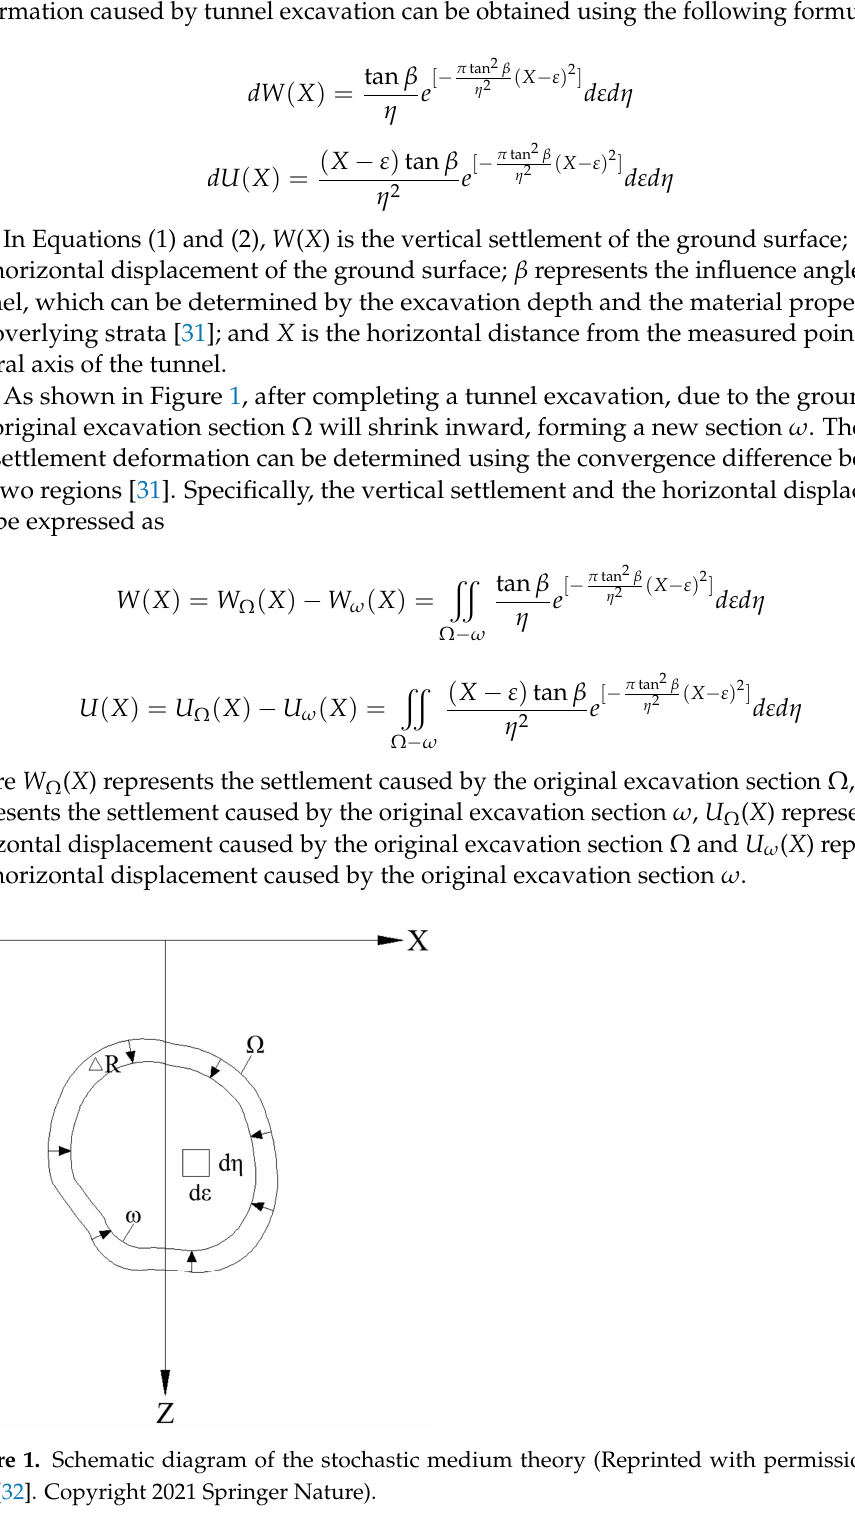
( b ) Figure 2. Horseshoe section of a tunnel: ( a ) uniform convergence and ( b ) non-uniform convergence. (Reprinted with permission from Ref. [32]. Copyright 2021 Springer Nature.). For the horseshoe tunnel section, under the condition of uniform convergence, the uplift of the fl oor is zero, and the tunnel section will move down by Δ R compared with the uniform convergence. In fact, fl oor heave is inevitable during excavation because of the induced stress release. According to Han and Li [33], the cross-section of a horseshoe tunnel can be divided into a semi-elliptical cross-section and a rectangular cross-section, and its horizontal deformation can be obtained via superposition of the two as follows: ( ) ( ) ( ) rrectangulaelliptical XUXUXU += (5) where U(X) elliptical is the horizontal displacement caused by the ellipse part (given brie fl y as U(X) e ); U(X) rectangular is the horizontal displacement caused by the rectangular part (given brie fl y as U(X) r ). U(X) e can be calculated using the following equation: